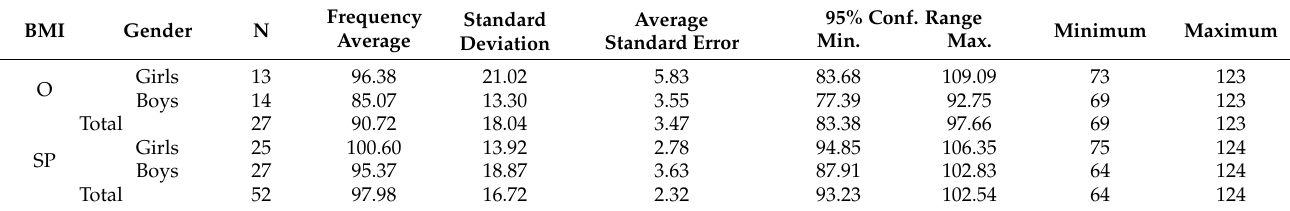
Table 5. Total physical activity by body mass index and gender.